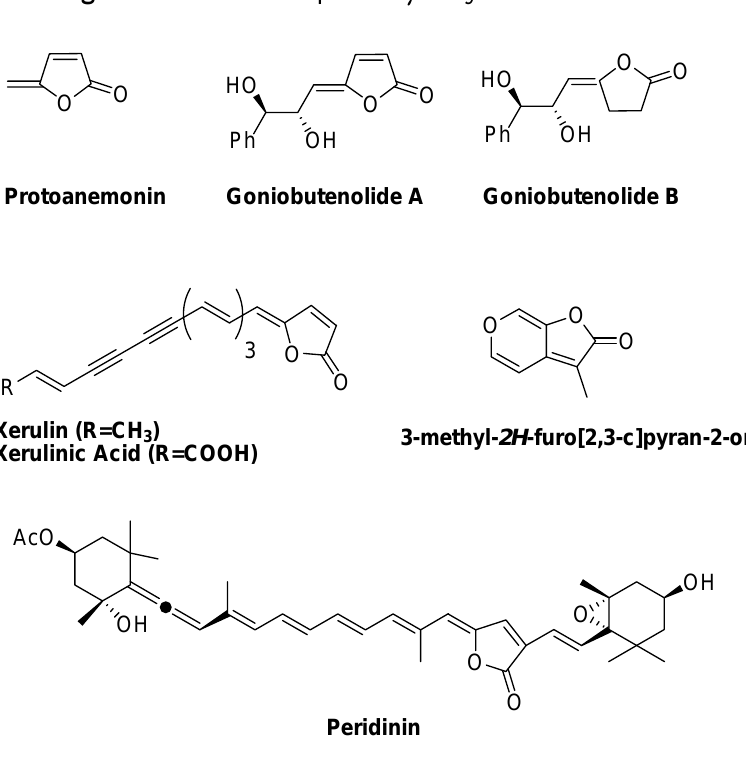
Figure 1 . Some examples of γ